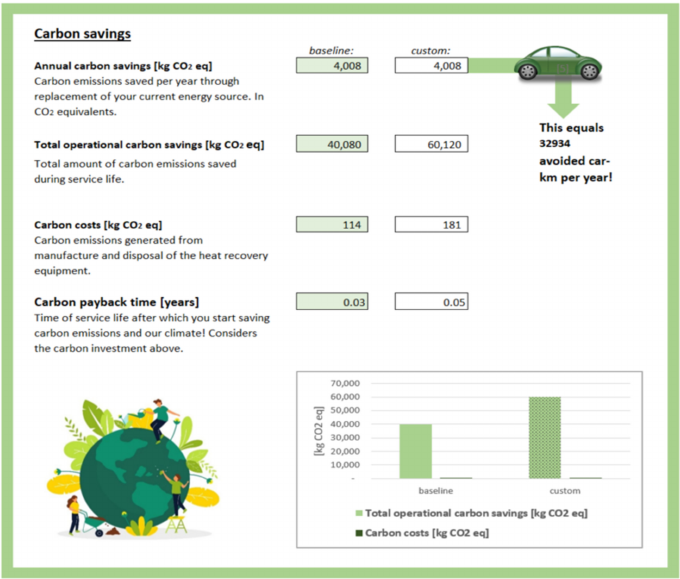
Figure 4. Example for results on carbon costs (footprint) and savings from the heat recovery toolkit. Assumptions: see Figure 3. With graphical element modified from [42].